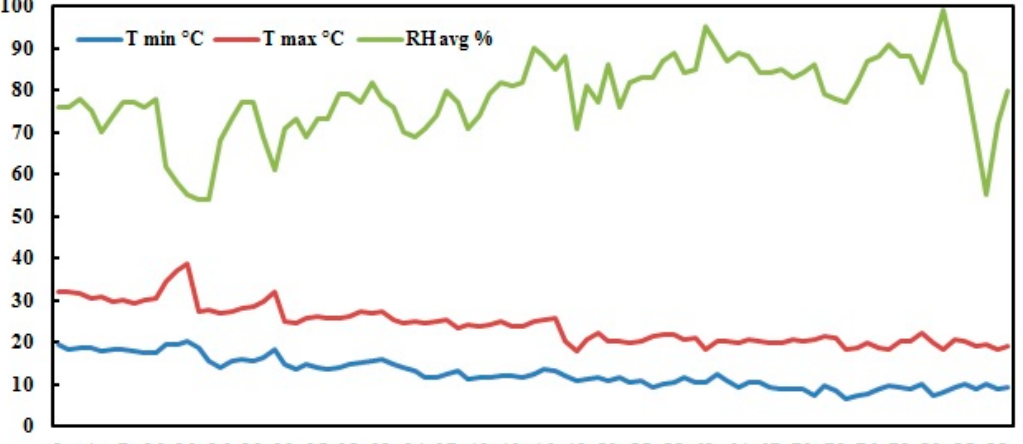
Figure 3. The data of maximum temperature, minimum temperature and relative humidity, obtained from weather station installed at the experimental station of National Research Centre, Nubaria region, Egypt.